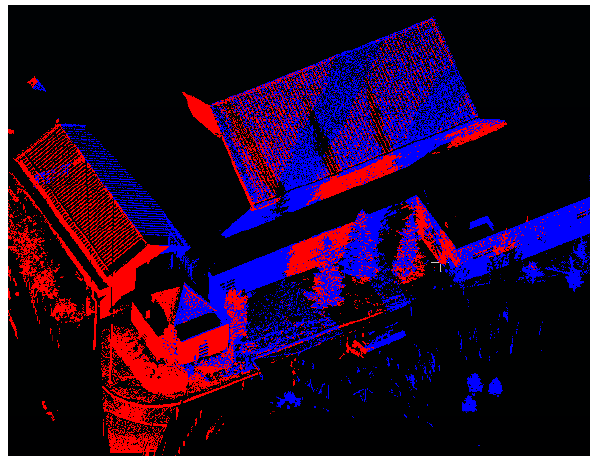
Figure 6. The two sub sampled point clouds of Rozsa center after registration